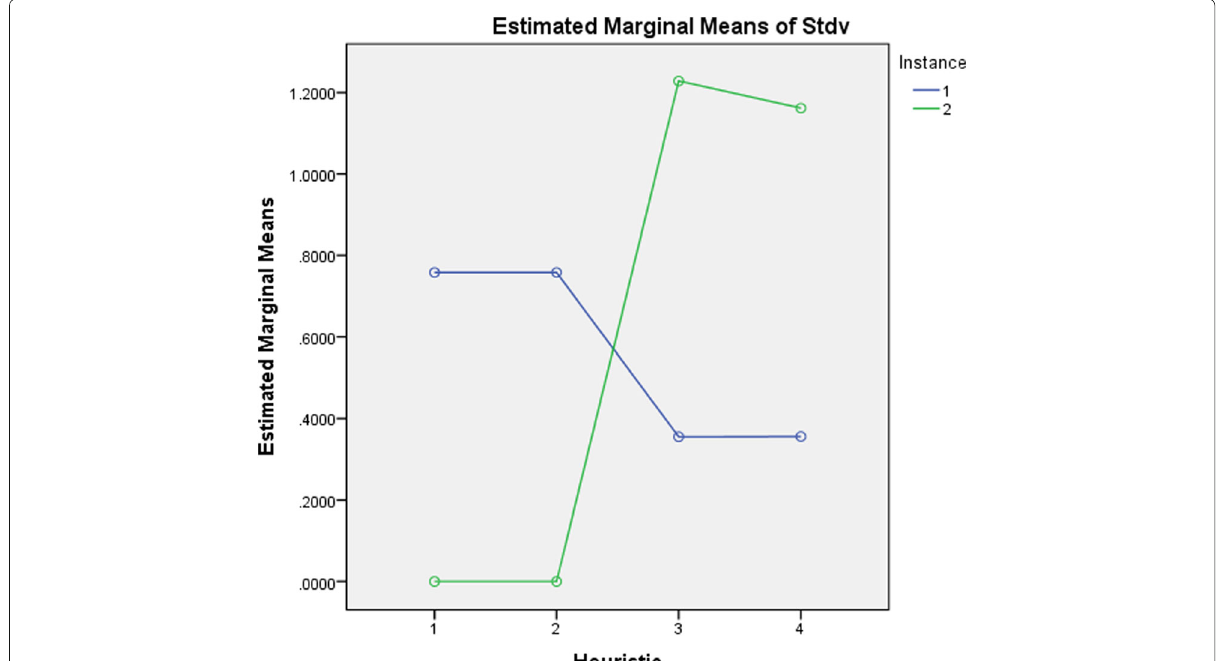
Fig. 12 Quality of solution-